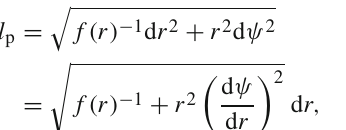
Fig. 5 Observationalappearancesofageometricallyandopticallythin disk with different profiles near black hole with M = 1, a = 0 . 05, w = − 0 . 5, viewed from a face-on orientation. The left column shows the profiles of various emissions I em ( r ) . The middle column exhibits